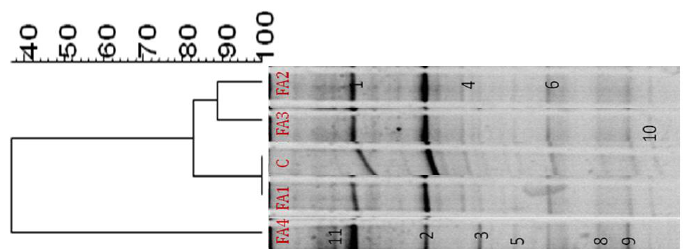
Figure 1. Negative image and similarity index of 16S rRNA DGGE amplified using total genomic DNA extracted from in vitro fermenta of swine fecal slurry added with different phytogenic feed additives. C: control; FA1, red ginseng barn powder; FA2, persimmon leaf powder; FA3, ginkgo leaf powder; FA4, oregano lippia seed oil extract